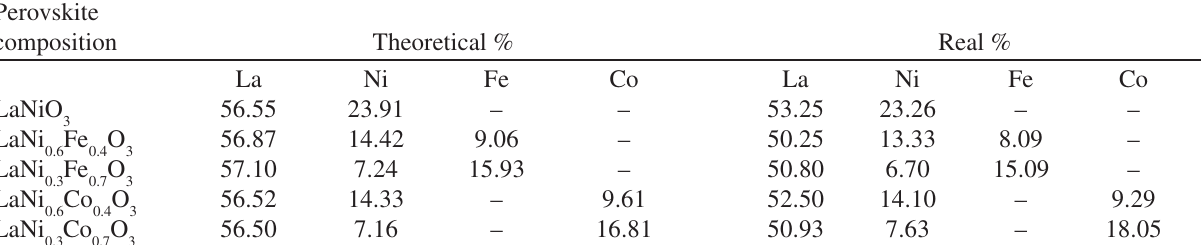
Figure 3. LaNiO precursor - method 1. a) Scanning electron microscopy micrograph of particle 1, b) energy dispersive X-ray spectrometry 3 of particle 1. Table 1. Inductively coupled plasma atomic emission spectroscopy analyses. Perovskite